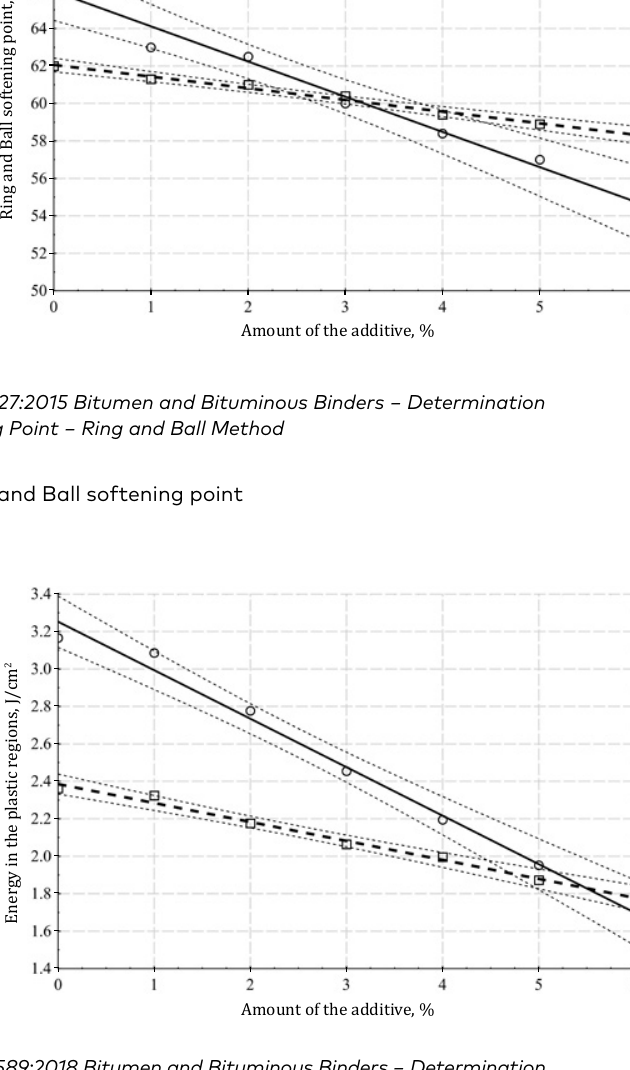
Figure 8a. Conventional energy in the plastic regions in the force ductility